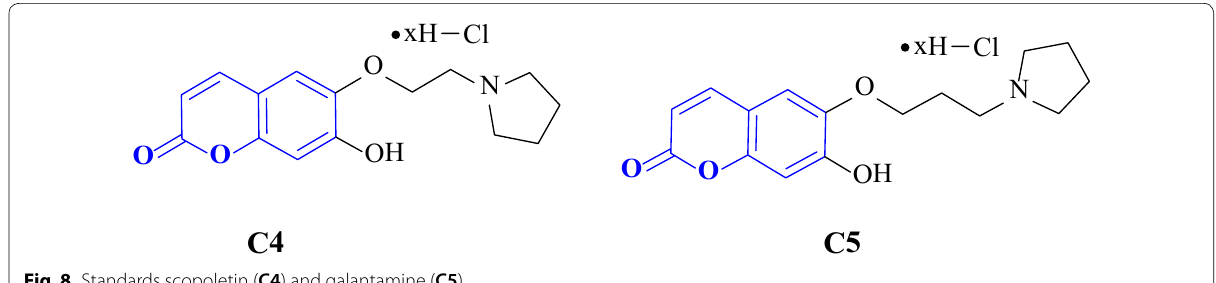
Fig. 8 Standards scopoletin ( C4 ) and galantamine ( C5